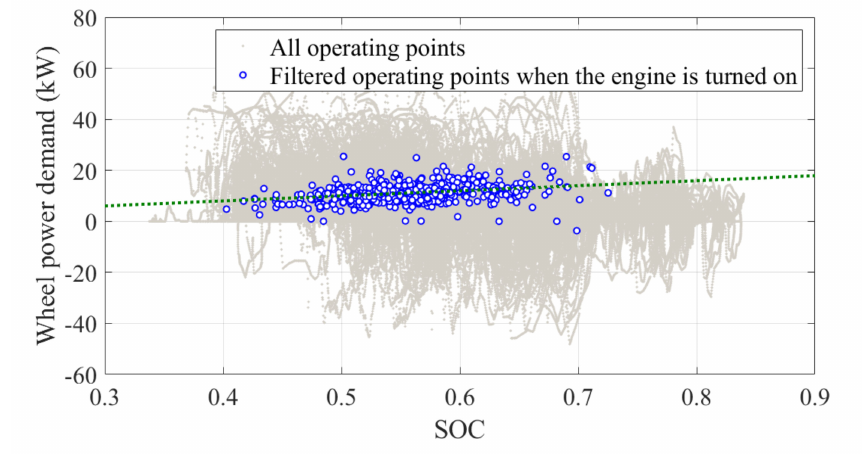
Figure 11. Operating Points When the Engine is Turned on According to the SOC